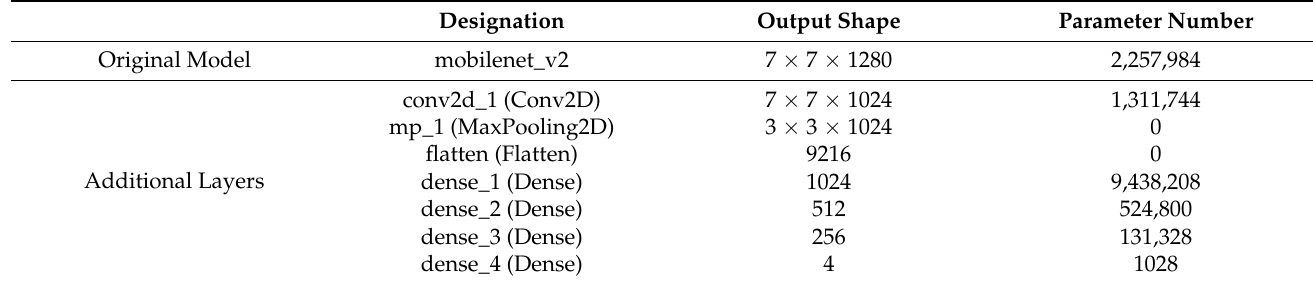
Table 8. The proposed modified-based MobileNet V2 model architecture.